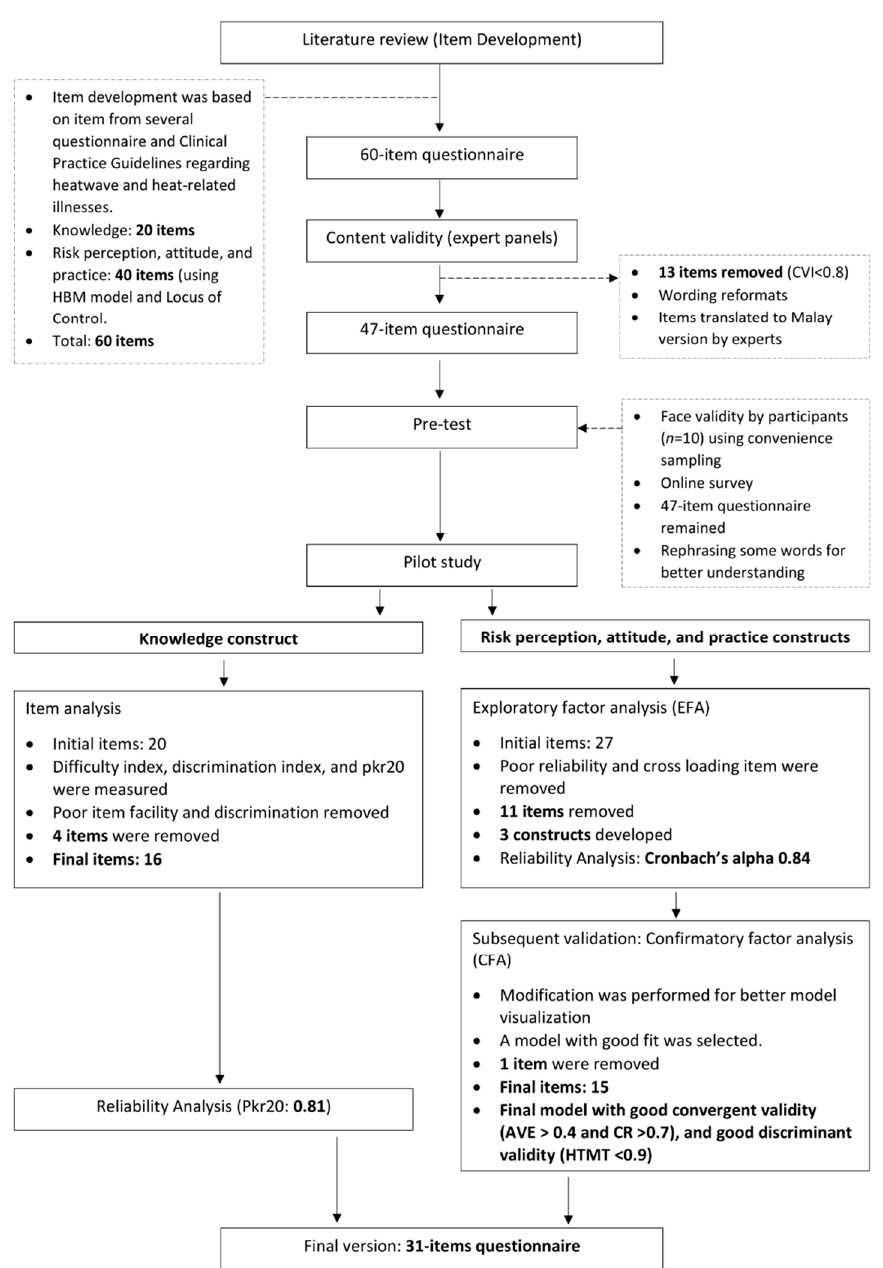
Figure 2. Flowchart of the Malay-version of KRPAP questionnaire development and construct.